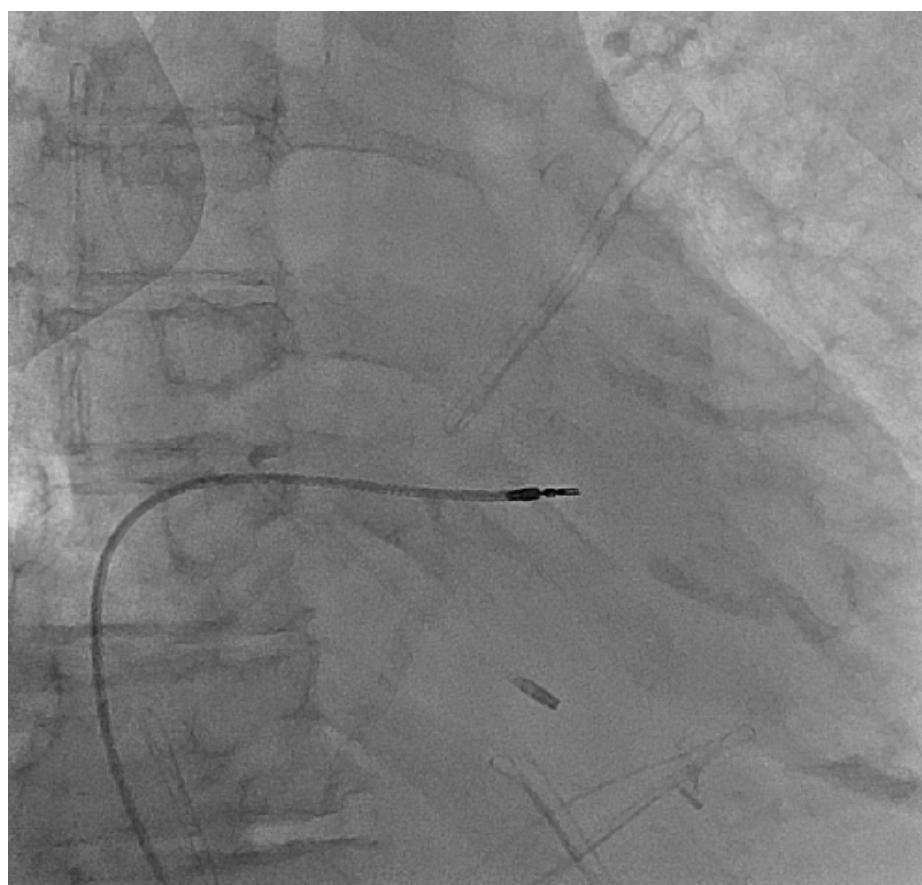
Figure 1. Chest X-ray in posteroanterior view with temporary pacing electrode introduced from right groin and remains of the ventricular electrode after incomplete transvenous lead extraction.